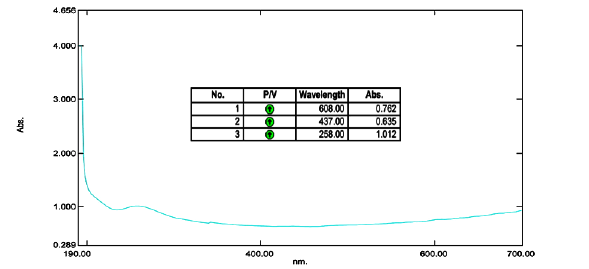
Figure 5. The UV-vis spectra of synthesized Fe 3 O 4